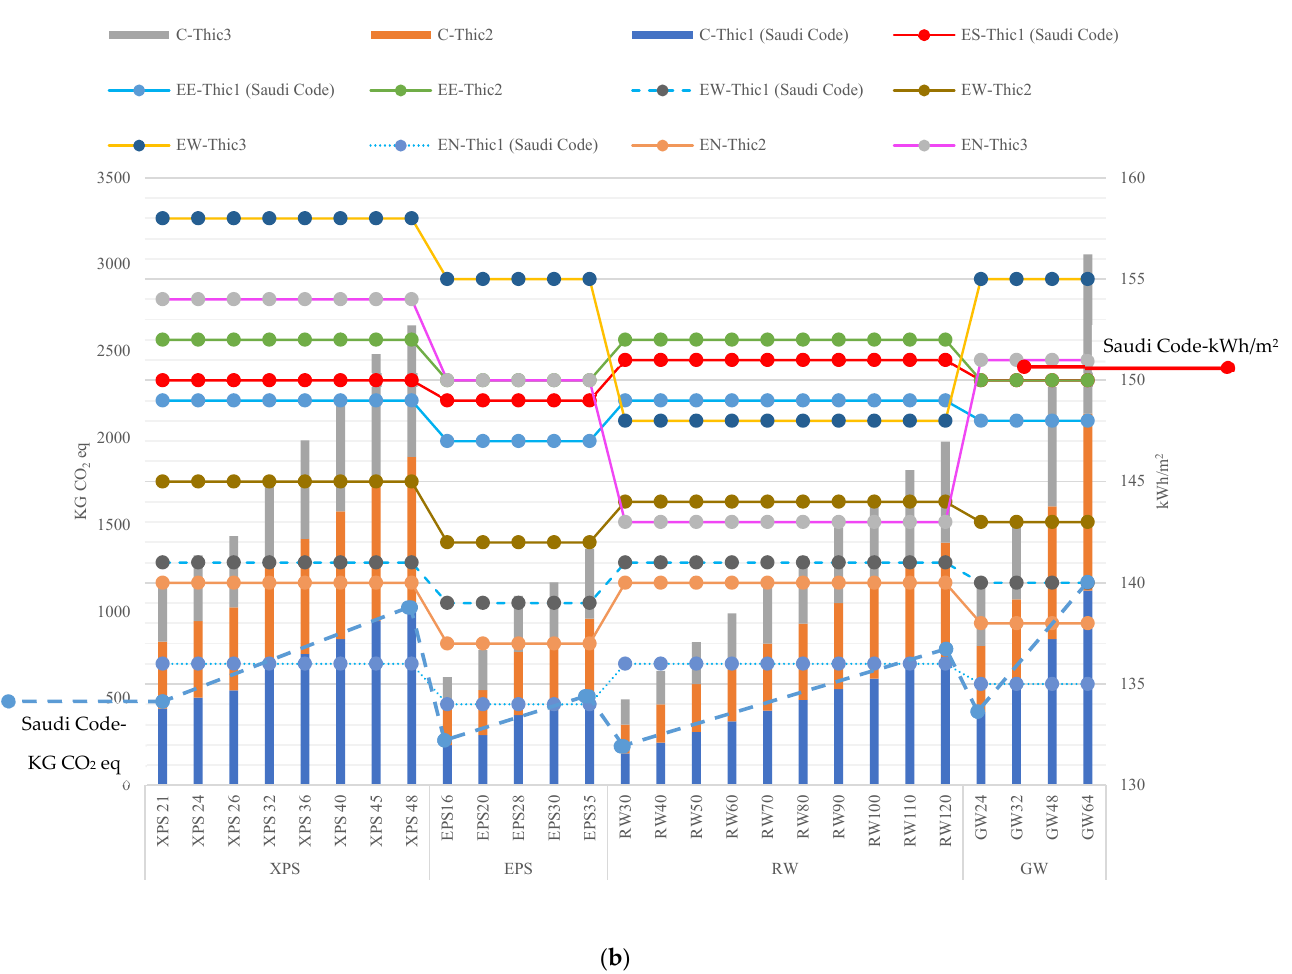
Figure 14. Optimization chart for all thermal and environmental aspects based on ( a ) Overall kWh\m 2 and kg CO 2 eq respectively, ( b ) Based on SBC.